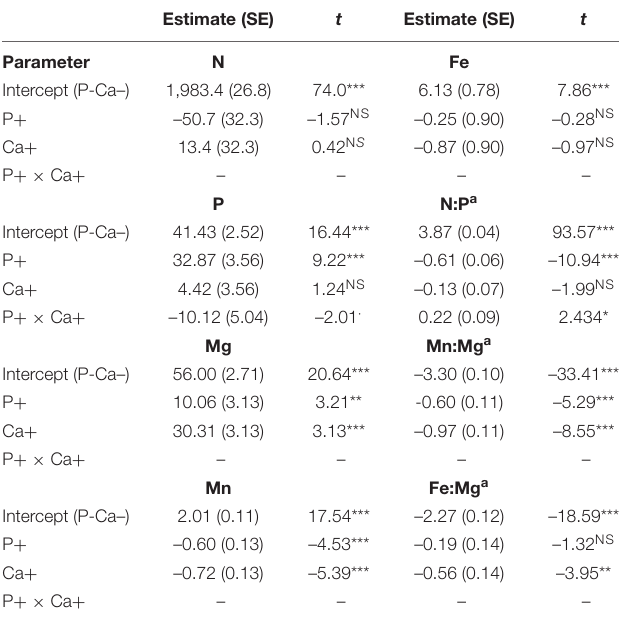
TABLE 2 | Model summaries for plant chemistry treatment effects.